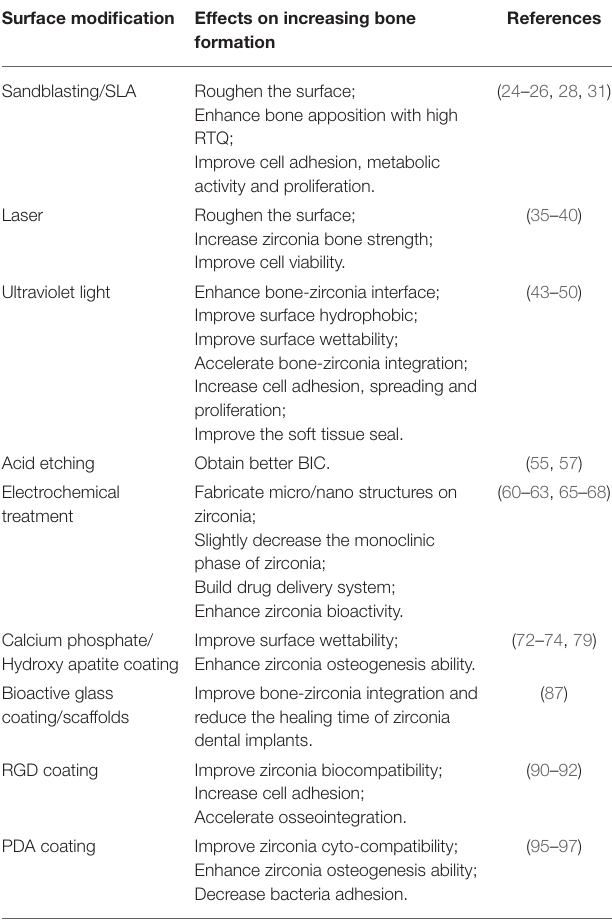
TABLE 1 | Strategies for bone tissue engineering through surface modifications on zirconia-based materials in